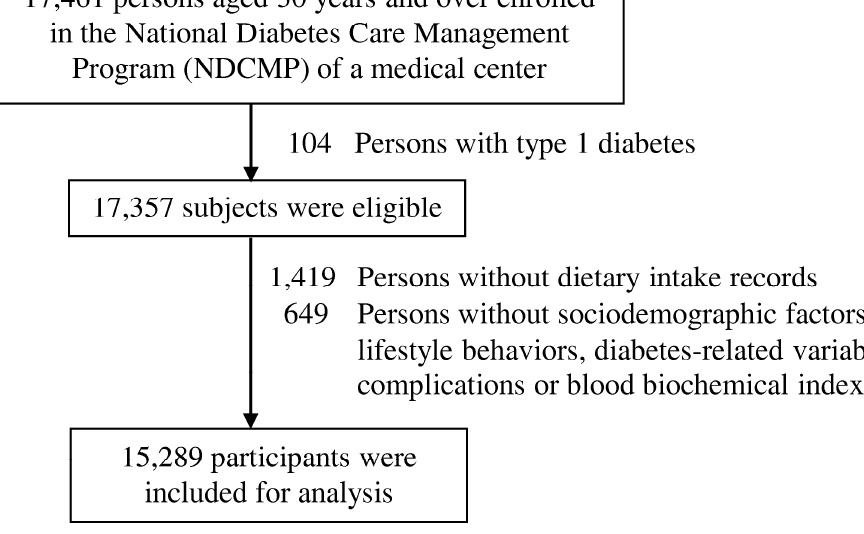
Figure 1. Flowchart of recruitment procedures for the current study.